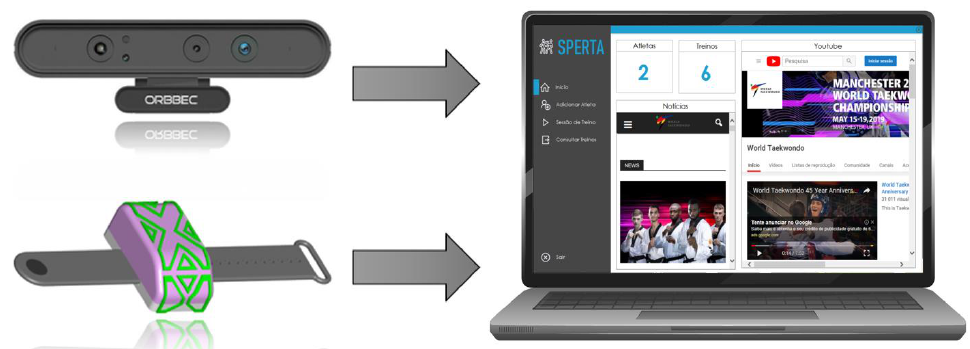
Figure 4. Framework system architecture.